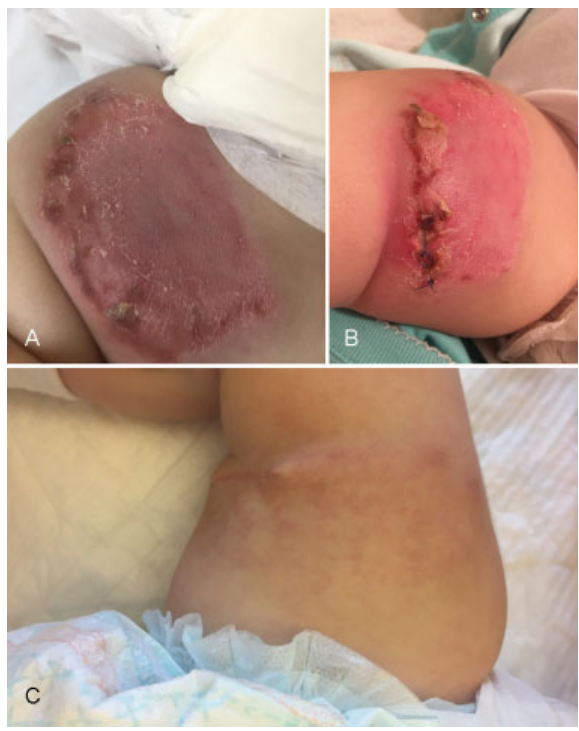
Fig. 1 ( A ) The clinical picture of the right thigh after 2-months of conservative treatment; ( B ) the lesion of the thigh after surgical biopsy (visible skin sutures) that con fi rmed the diagnosis; ( C ) the same skin surface after 4 months of chemotherapy.